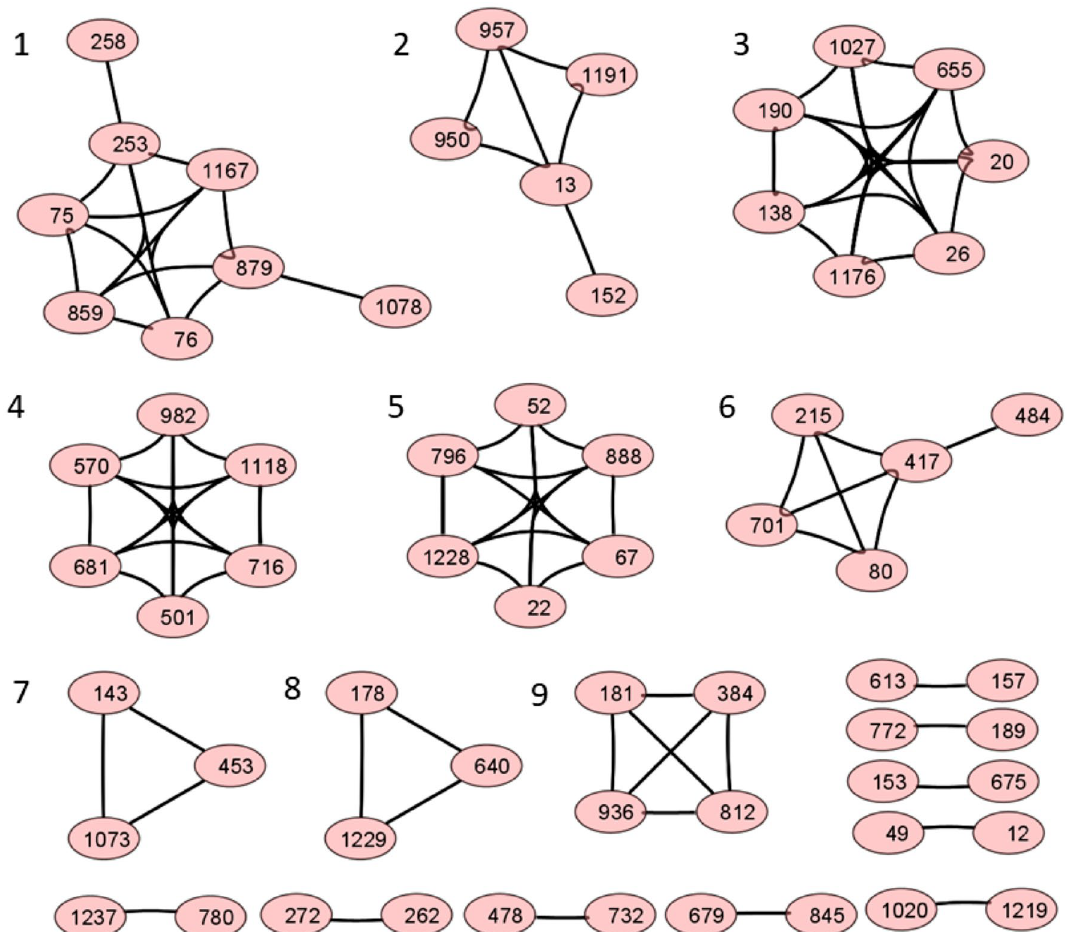
an amino acid position on the SARS-CoV2 wild type sequence. Several clusters have mutations that are characteristic of variants of concern, e.g. amino acids (N501, P681, T716, S982, A570 and D1118) in cluster 4 represent signature mutations in the Alpha variant, while those in cluster 6 correspond to the Beta